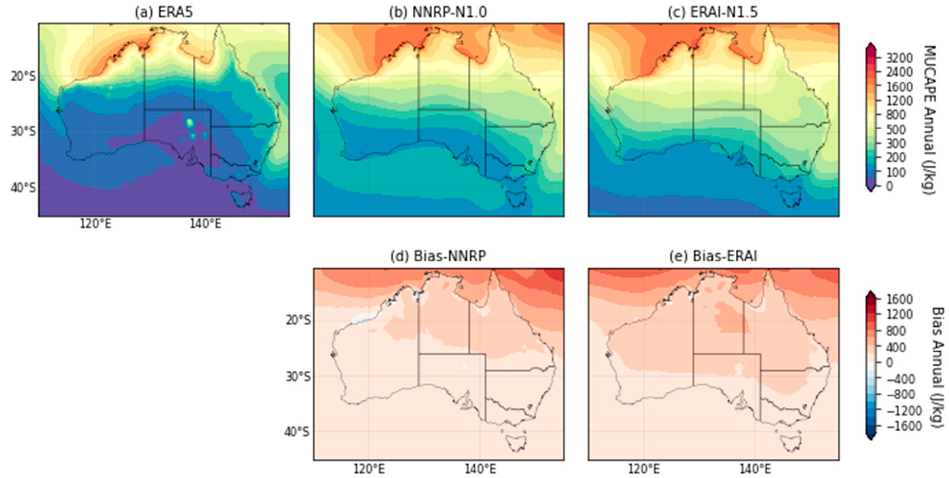
Figure 5. Climatology of annual MUCAPE in d01 from ( a ) ERA5, ( b ) NNRP-N1.0 and ( c ) ERAI-N1.5. ( d , e ) are the biases of NNRP and ERAI from ERA5, respectively. Unit: J kg − 1 .